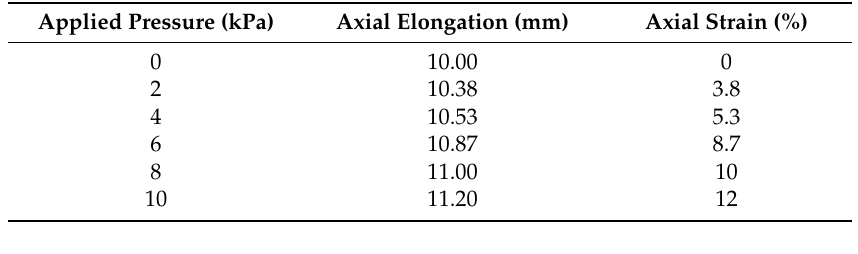
Table 3. The elongation and strain of the membrane induced by different pressures.